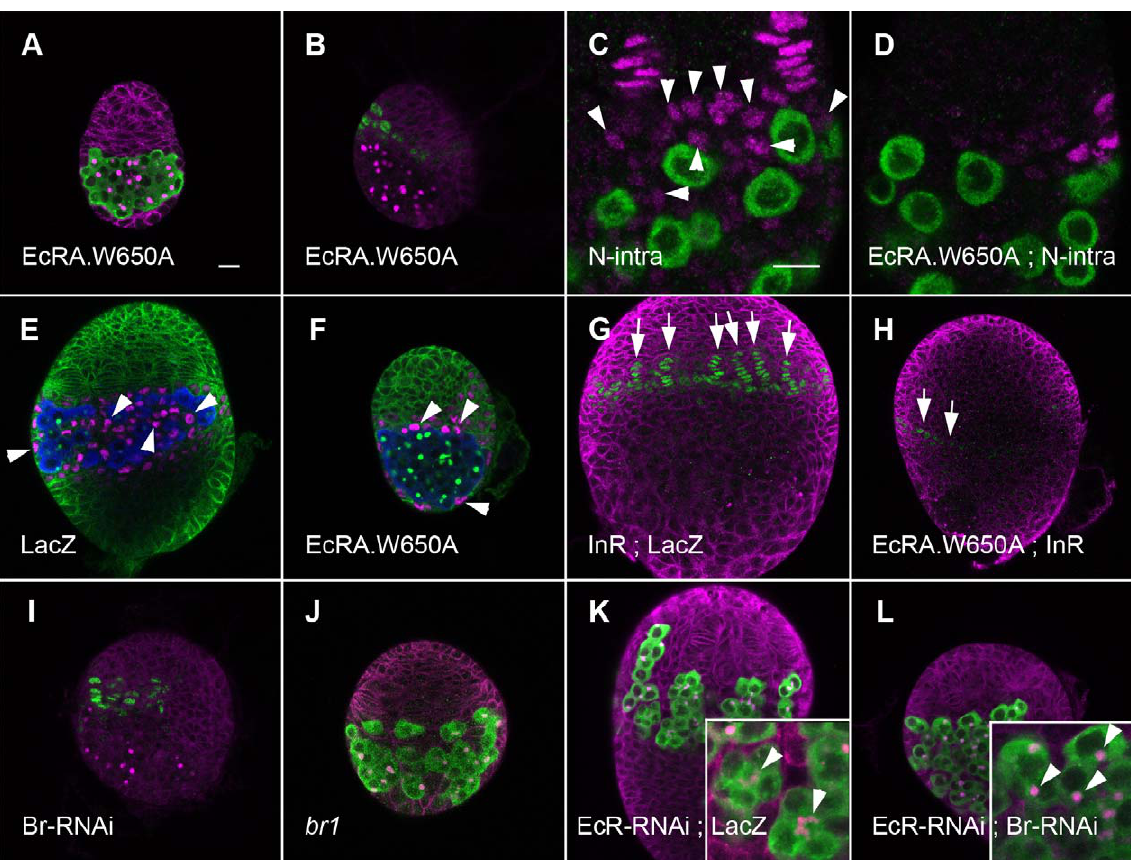
Figure 4. Gonad development requires ecdysone signaling and Broad expression. In all panels except (C, D), 1B1 antibody labels fusomes and outlines somatic cells. (A) Anti-Vasa (green) labels PGCs. EcRA.W650A LL3 ovaries are much smaller than wild type ovaries (compare Figure 4A to Figure 1G). (B) EcRA.W650A ovaries contain very few TF cells ( hh -LacZ, green), which are not organized into stacks (compare Figure 4B to Figure 2H). (C, D) TF and cap cells are labeled by anti-En (magenta). PGCs are labeled by anti-Vasa (green). (C) Expression of N-intra greatly increases the number of En-labeled cap cells at the base of TFs (arrowheads). (D) Cap cells are not observed in EcRA.W650A ovaries. (E, F) ICs are labeled by anti-Tj (magenta) and are located next to PGCs (anti-Vasa, Blue). 1B1 labeling is green. (E) In wild-type, no Tj labeling is observed at the anterior at LL3. ICs intermingle with PGCs. (F) In EcRA.W650A ovaries, ICs lie outside of the PGC region. As in wild type, no Tj staining is observed at the anterior. (G–I) TFs are labeled by hh -lacZ (green). (G) Ovaries over-expressing InR are larger and contain fully formed TF and cap cells (arrows). (H) Over-expression of InR in EcRA.W650A rescues gonadal size. However, very few TF cells are specified (arrows), which are not organized into stacks. (I) Fewer, shorter TFs are present in br -RNAi ovaries. (J) br 1 LL3 ovaries are small with less developed TFs. (K, L) Precocious cysts and TFs in EcR -RNAi ovaries (K, inset, arrowheads) are not observed when ovaries also lack broad (I, inset, arrowheads). Bars in (A) (for A, B, E–L) and in C (for C, D) are 10 m m.